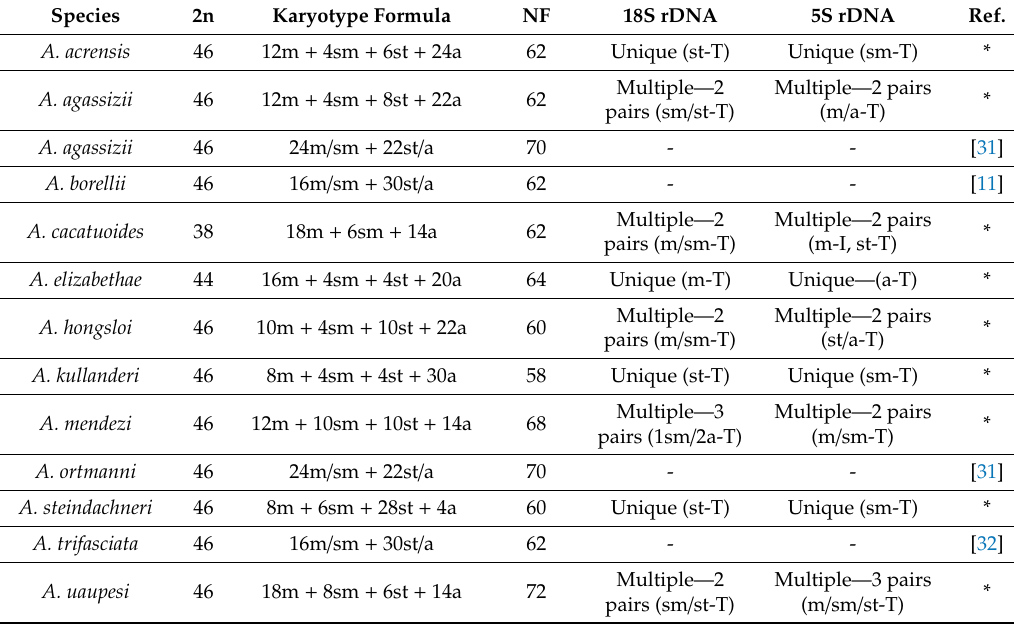
Table 1. Cytogenetic data of Apistogramma species.